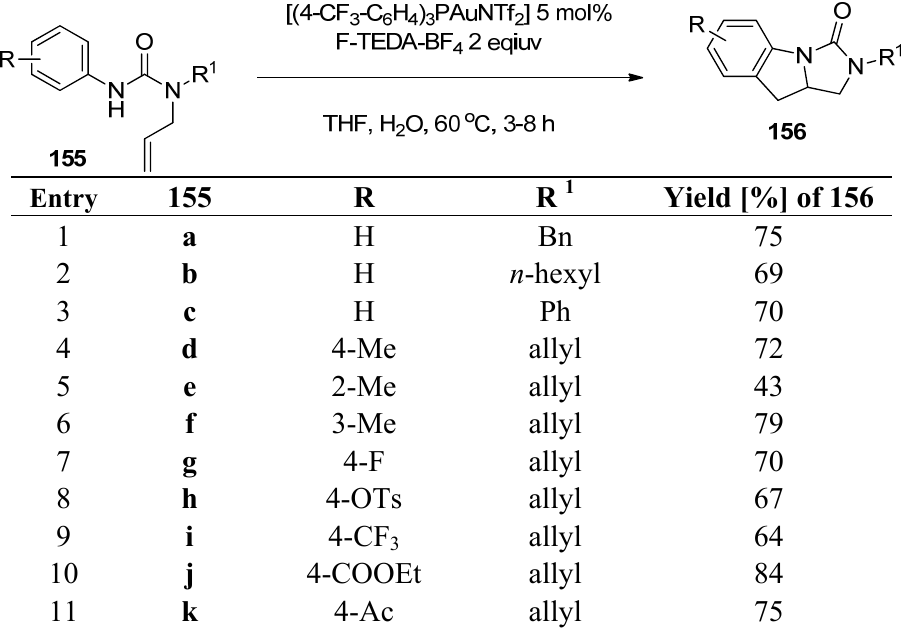
mediated C-C coupling through C-H 4